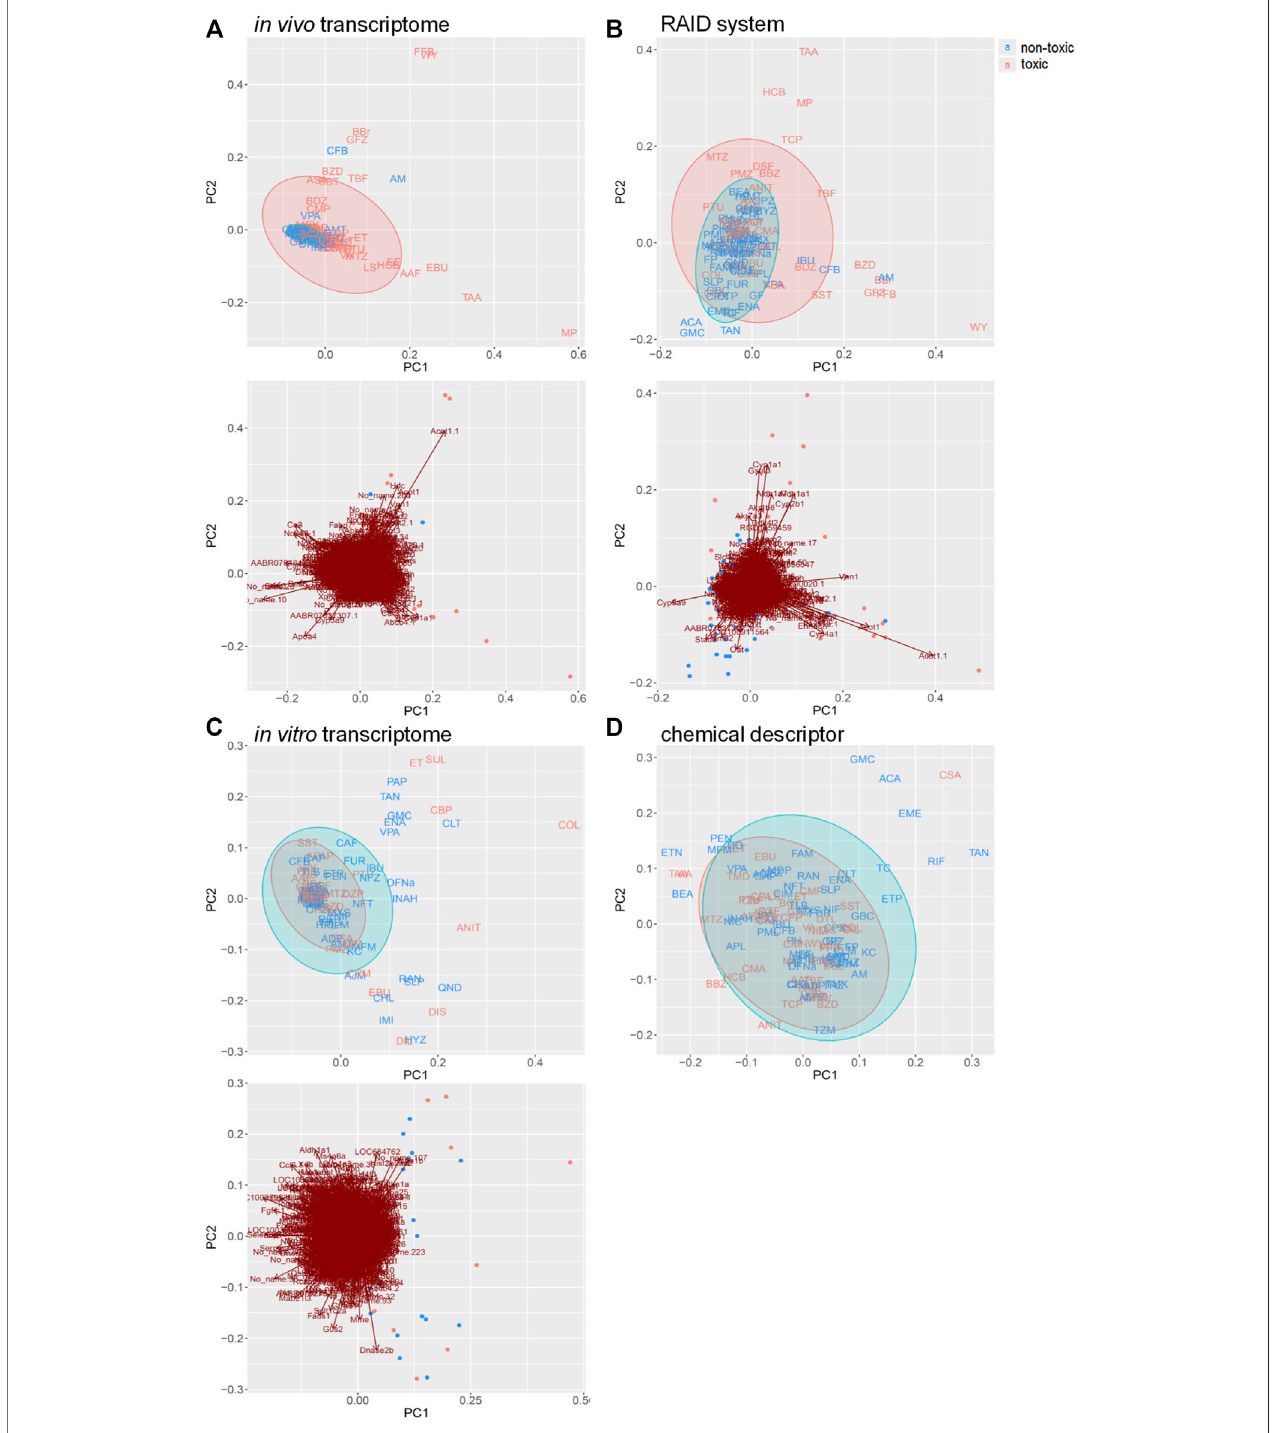
FIGURE2| PCAscoreplotsforchemicalsubstancesandthegeneloadinginthetranscriptomedataof (A) invivo , (B) virtualmicroarray(RAID),and (C) invitro data. PCA score plot with (D) chemical descriptor data. Uppercase letters in PCA score plots: abbreviations of chemical substances are described in Table 1 . Blue: nontoxic substances. Red: hepatotoxic substances. Gene symbols are presented on the arrowhead (loading).